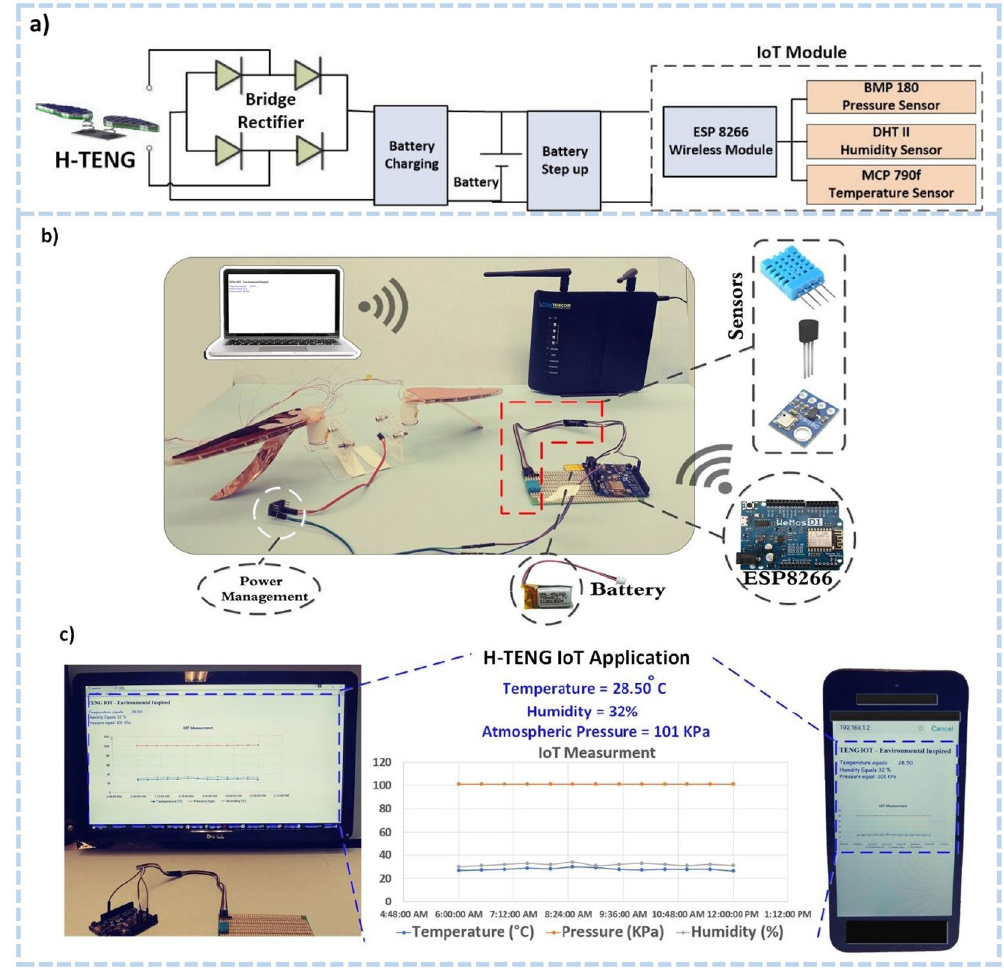
Figure 4. ( a ) A circuit diagram of the self-powered wireless environmental node (pressure-temperature- humidity) for IoT applications enabled by H-TENG. ( b ) The power management circuit, battery, router, environmental sensor node, H-TENG and a wireless module. ( c ) The temperature, pressure, and humidity are transmitted from the wireless sensor node system to a mobile and a computer screen. The inset figure shows the enlarged values of sensor outputs on a web browser in a laptop as its IoT